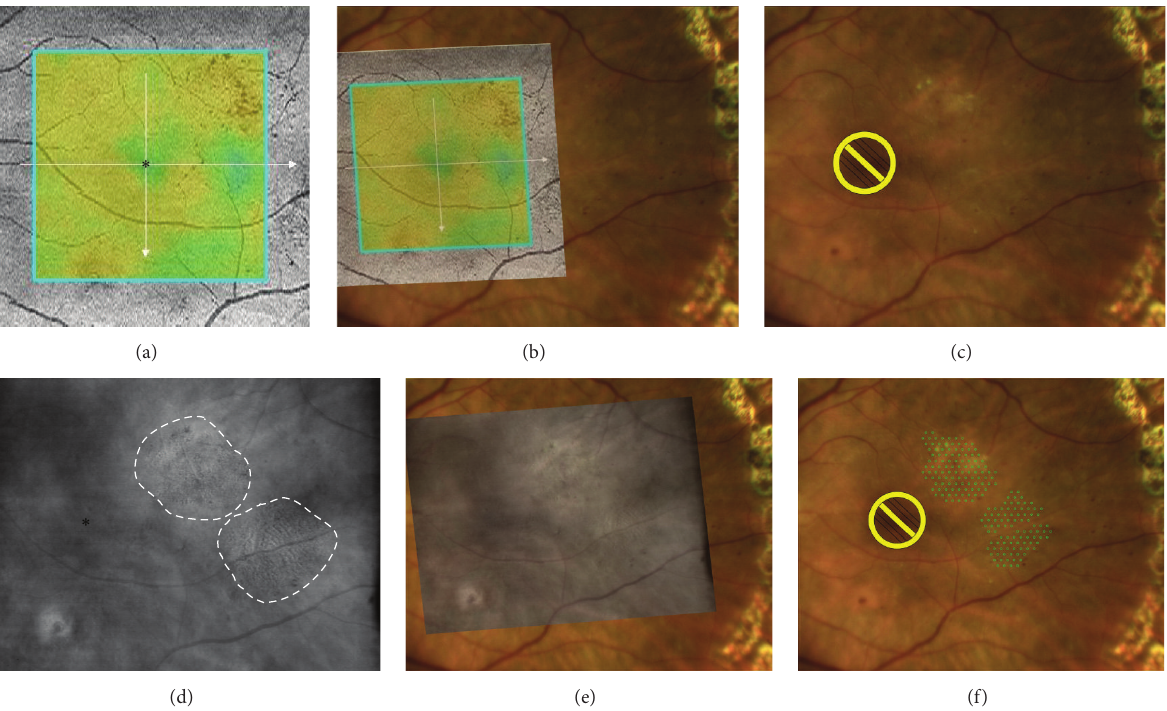
Figure 2: OCT- versus RM-SLO-guided treatment plan for macular laser photocoagulation. (a) Retinal edema is visualized on the OCT retinal thickness map (asterisk represents the foveal center). (b) OCT map is superimposed onto the baseline image. (c) Placing laser spot marks is impossible in this case of OCT-guided planning for macular laser photocoagulation. (d) Retinal edema zones (total area, 13.12 mm 2 ) are identified on the RM-SLO image (white dashed line represents the zone boundary; asterisk represents the foveal center). (e) RM-SLO image is superimposed onto the baseline image. (f) In RM-SLO-guided planning for macular laser photocoagulation, the number of laser spot marks was